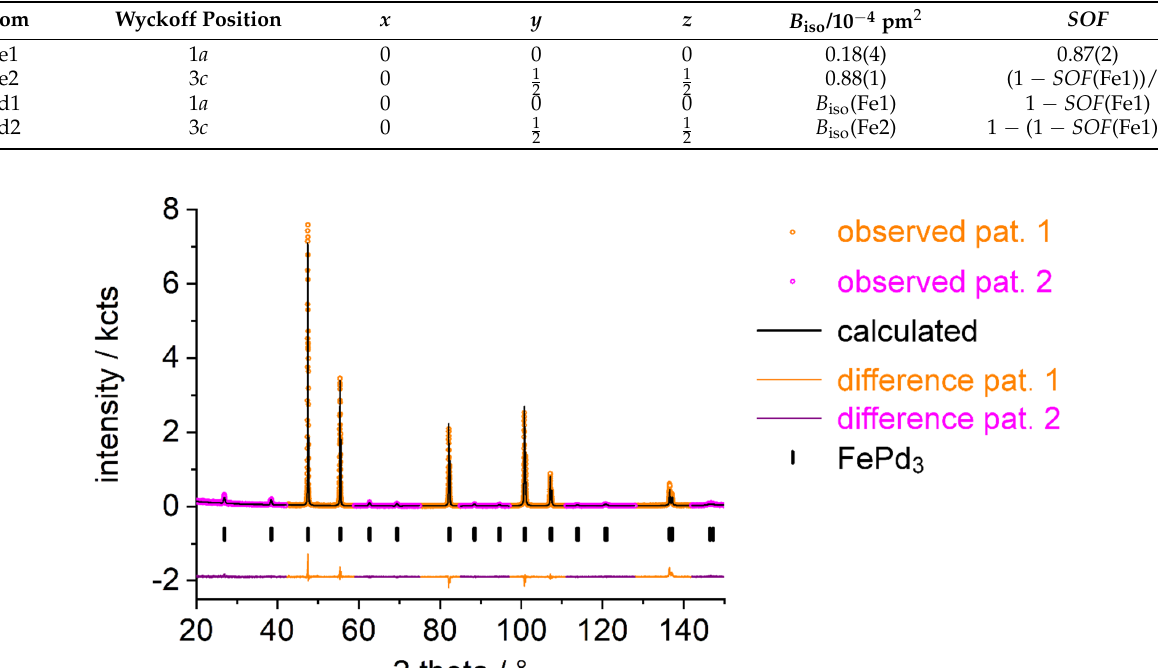
Figure A2. Rietveld refinement of the crystal structure of ordered FePd 3 (long-time annealed sample, AuCu 3 type, Pm 3 m , a = 385.412(4) pm, R Bragg (pat.1) =8.01, R Bragg (pat.2) = 27.1; for further details, see Table A2) at 296(1) K based on XRPD powder diffraction data (Co-K α radiation, Smart Lab, R p (pat.1) = 0.109, R p (pat.2) = 0.125, R wp (pat.1) = 0.161, R wp (pat.2) = 0.173, Χ ² = 3.79, background cor- rected: R ’ p (pat.1) = 0.147, R ’ p (pat.2) = 1.23, R ’ wp (pat.1) = 0.161, R ’ wp (pat.2) = 0.553) using FullProf [24].